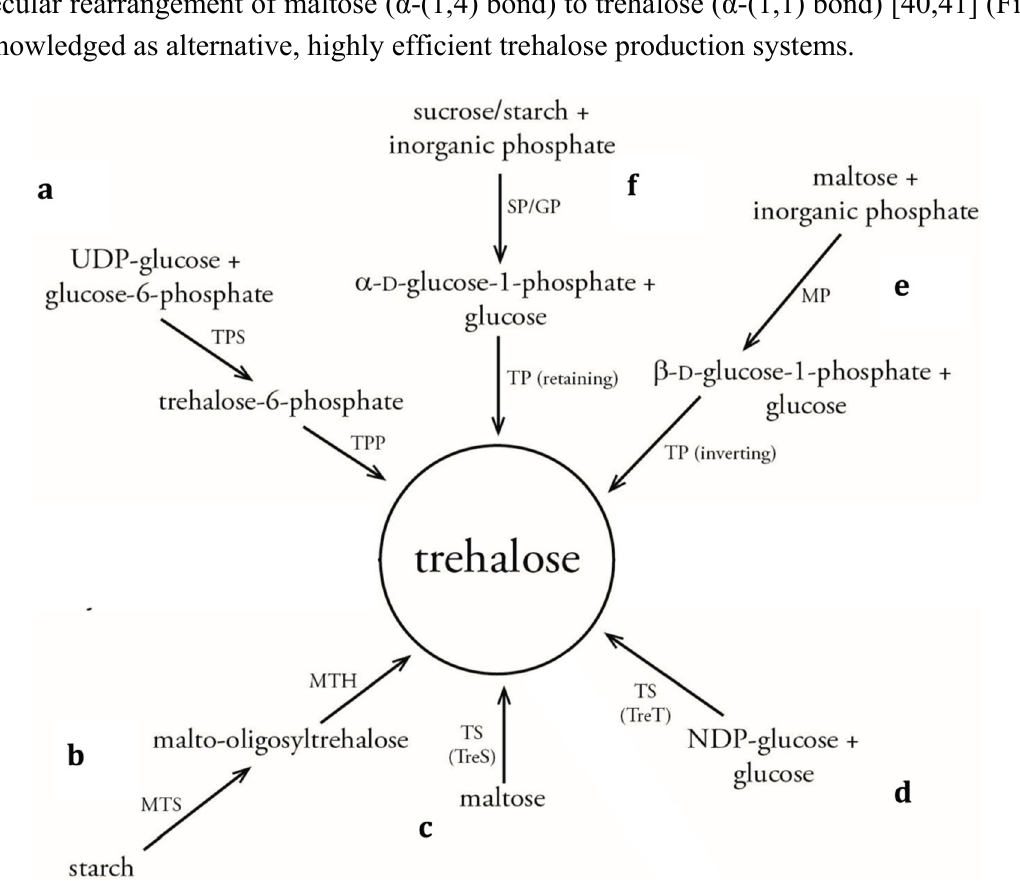
Figure 3. Schematic representation of biocatalytic pathways for trehalose